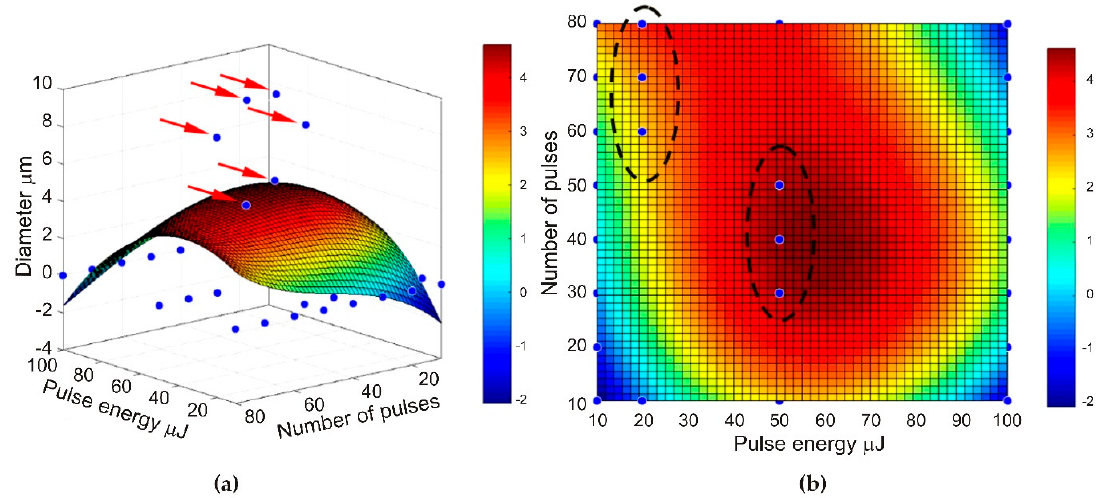
Figure 7. Optimization of graphene paper laser ablation parameters obtained using MATLAB: ( a ) 3D and ( b ) 2D.